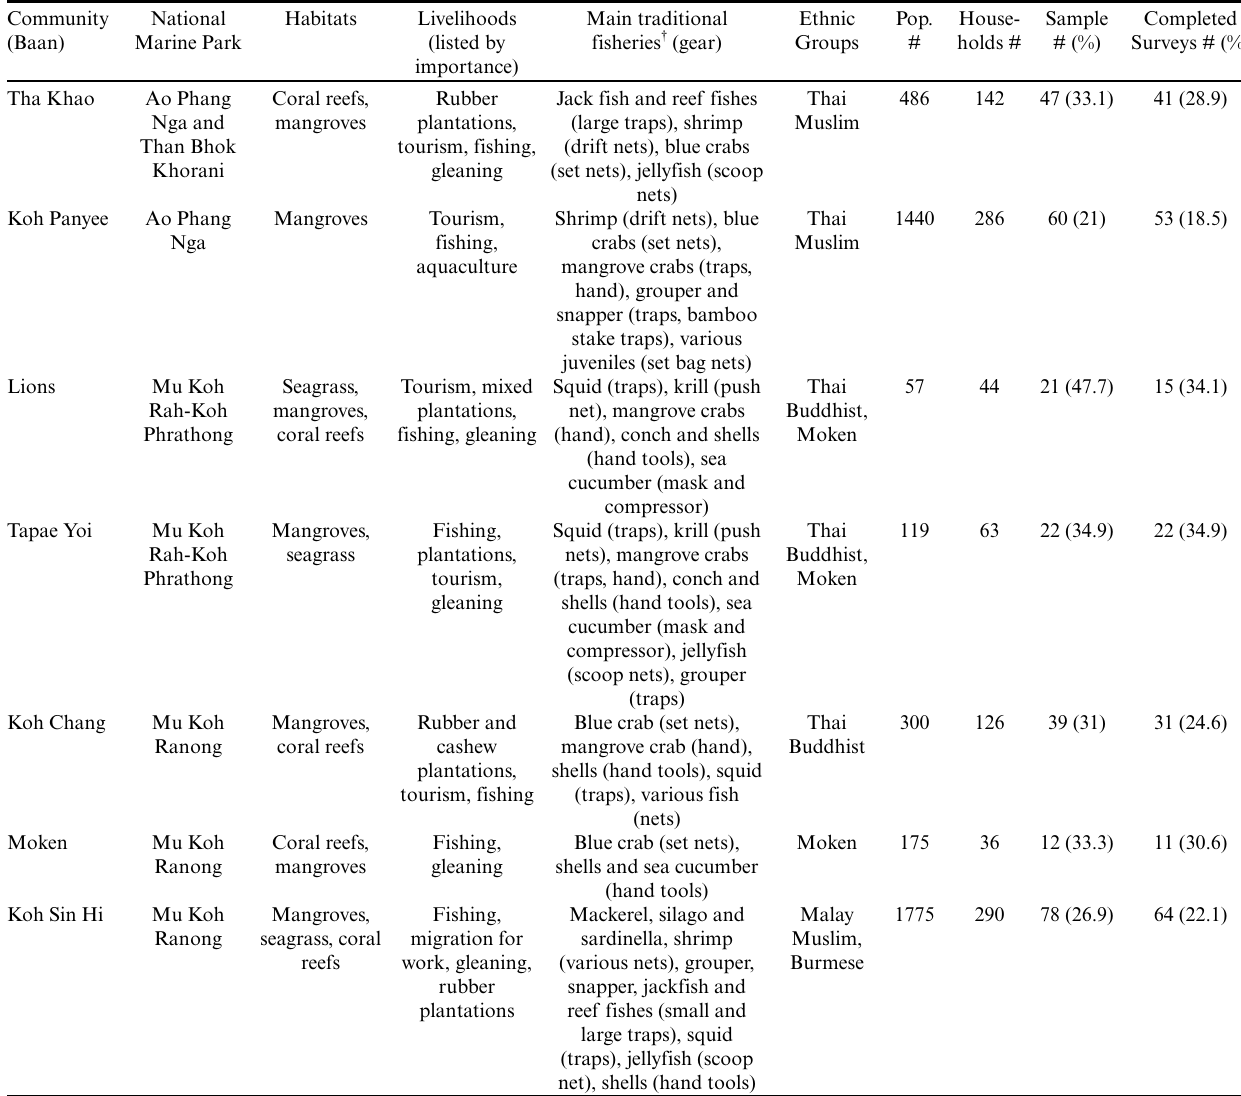
Table 2 . Community information and survey